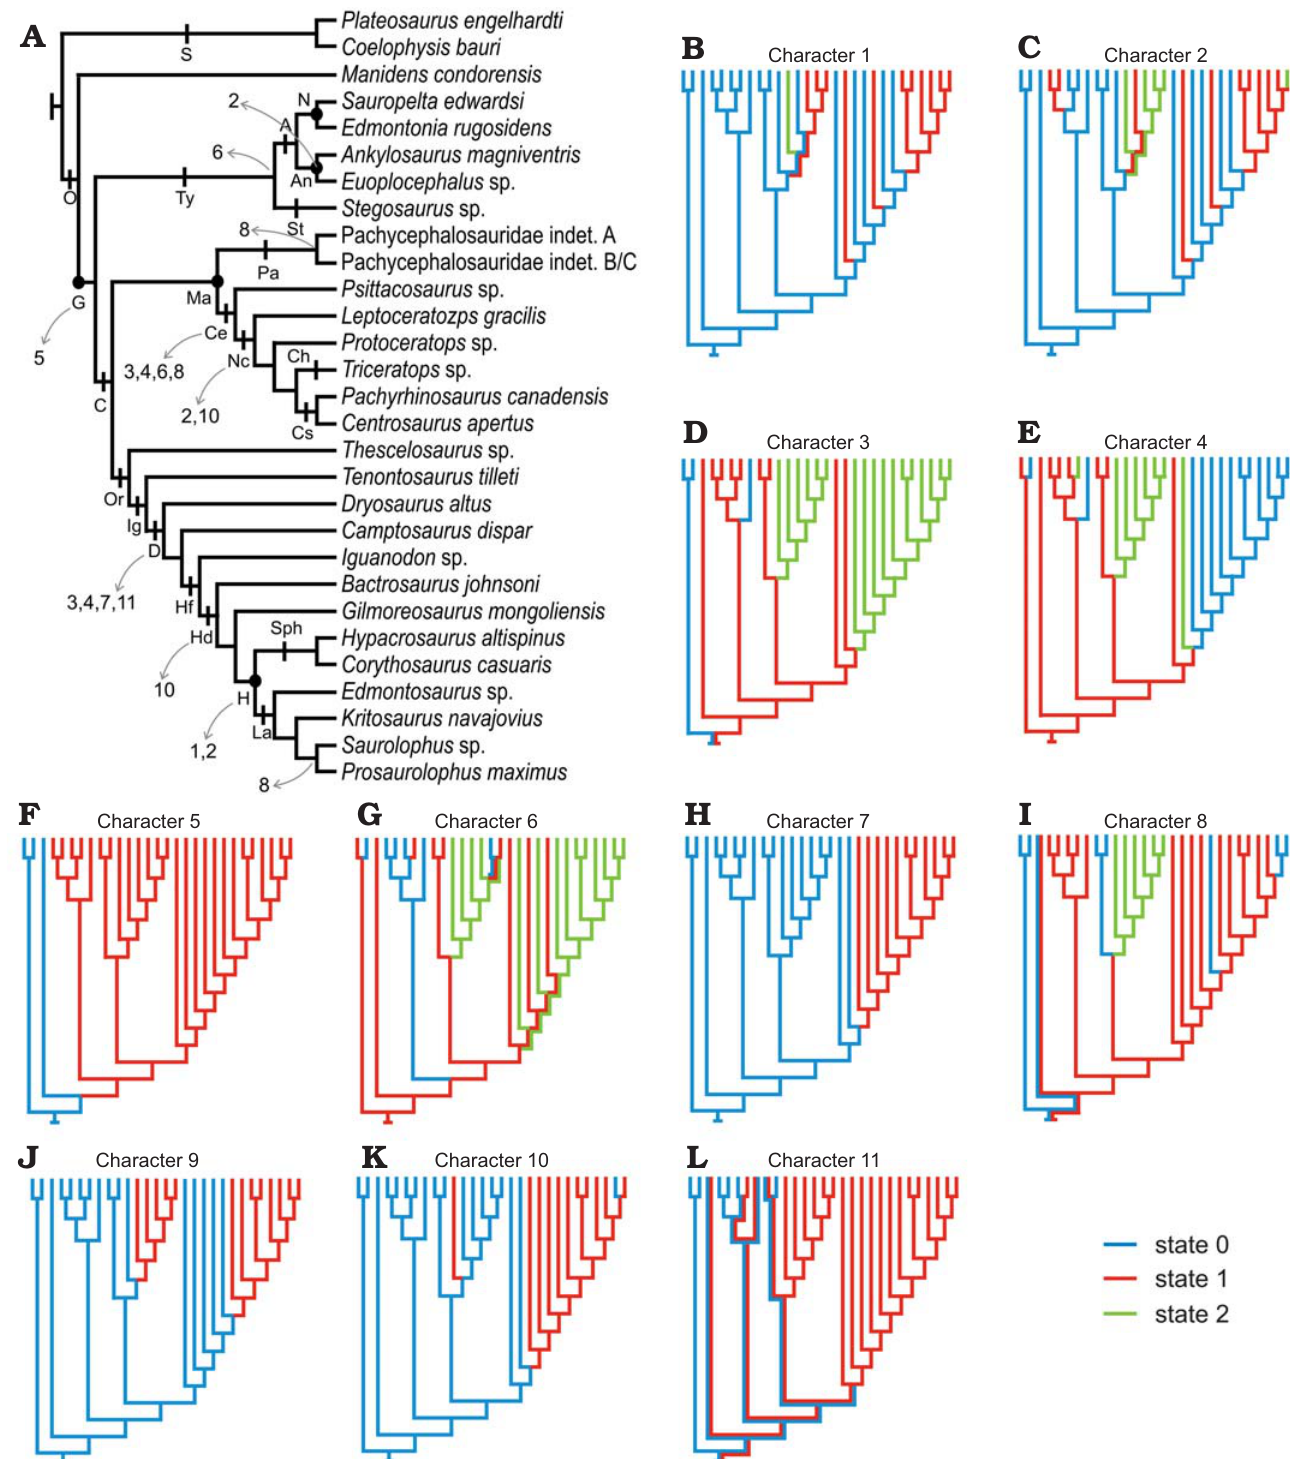
Fig. 5. Constructed topology based on the revised bibliography (see SOM). A . Phylogenetic topology comprising the ornithischian dinosaurs with known enamel micromorphology, indicating the represented major ornithischian lineages and the enamel characters recovered as synapomorphic of different groups (which can be optimized). B – L . Optimized character states in the topology expressed as different colours. Minimum enamel thickness ( B ),